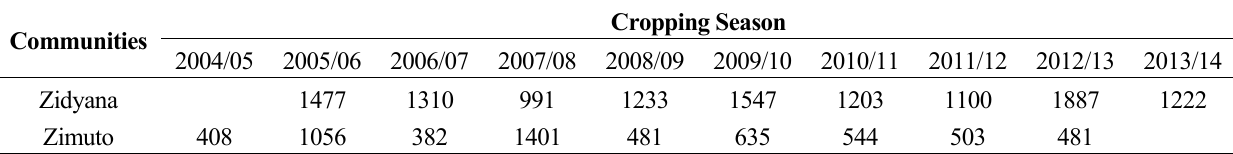
Table 2. Annual rainfall of the two target communities in Zidyana, Malawi and Zimuto, Zimbabwe.